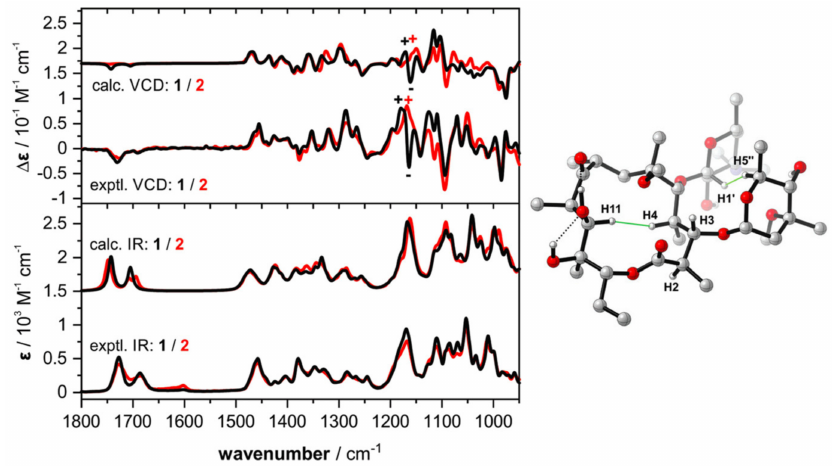
Figure 6. (( Left ) Comparison of experimental and calculated IR and VCD spectra of clarithromycin (1) and erythromycin (2). ( Right ) Lowest-energy conformer of clarithromycin adopting a “folded-out” conformation. Reprinted with permission from ref. [45]. Copyright 2020 Royal Society of Chemistry.